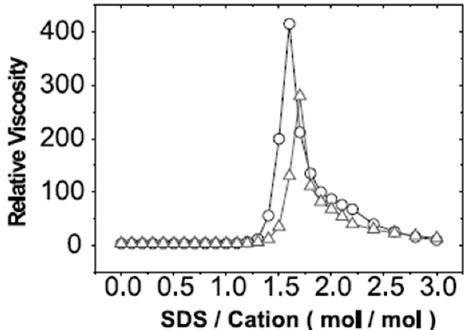
Figure 16. Relative Viscosity for ionene-SDS solutions versus molar ratio. Circle is 6,6-ionene, Diamond is 6,4-ionene. Reprinted from European Polymer Journal, 37, Zheng, X.; Cao, W. Interaction of main chain cationic polyelectrolyte with sodium dodecyl sulfate, 2259–2262, 2001 with permission from Elsevier. [137].